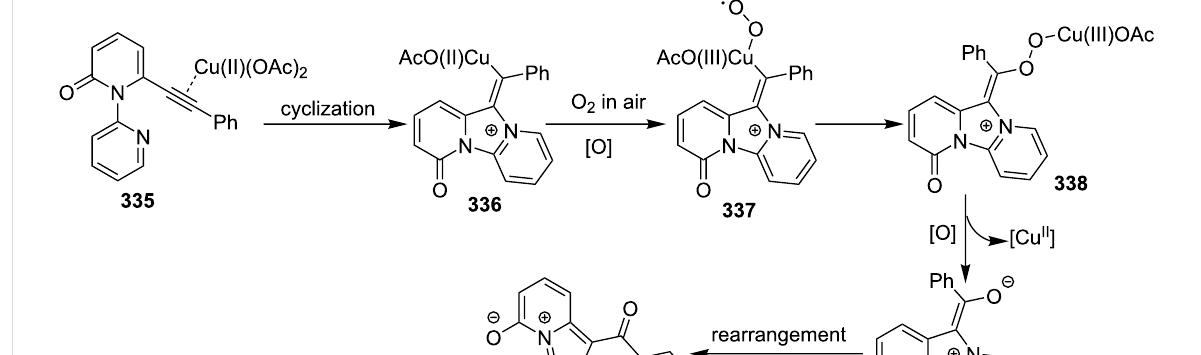
Scheme 110: Rh-catalyzed direct C–H alkynylation by Li et al.